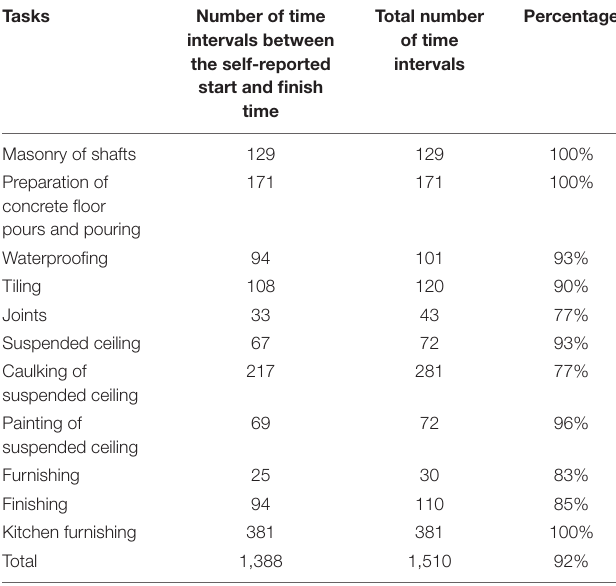
TABLE 5 | Count percentage of the recorded time intervals inside of the self-reported data of each task (the whole dataset). Tasks Number of time intervals